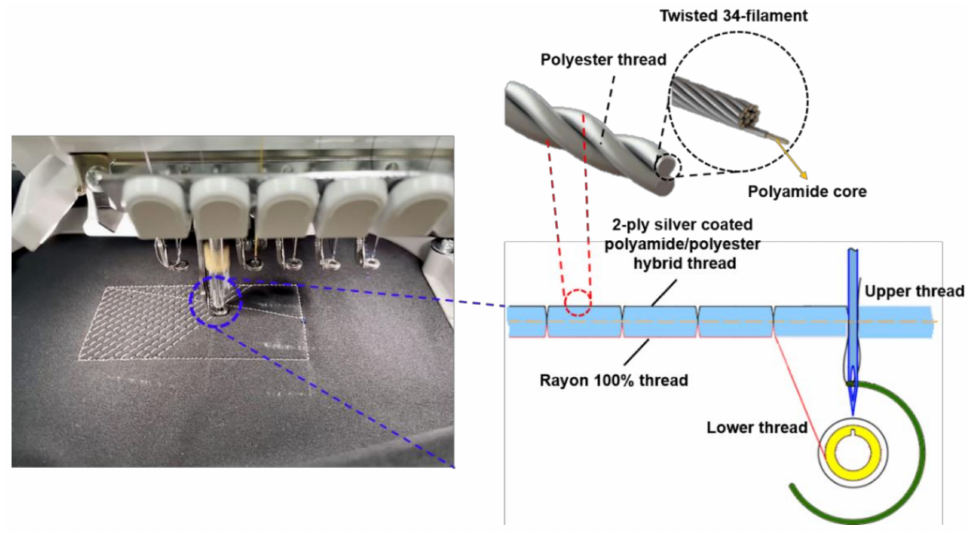
Figure 3. Embroidery